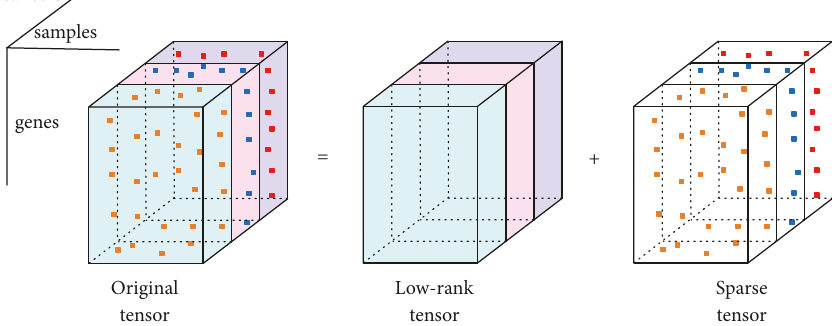
Figure 3: The TRPCA model of multiview data. Three dimensions represent genes, samples, and disease types, respectively. The solid color represents the data point equal to zero or close to zero, and a colored noise point denotes a disturbance signal.